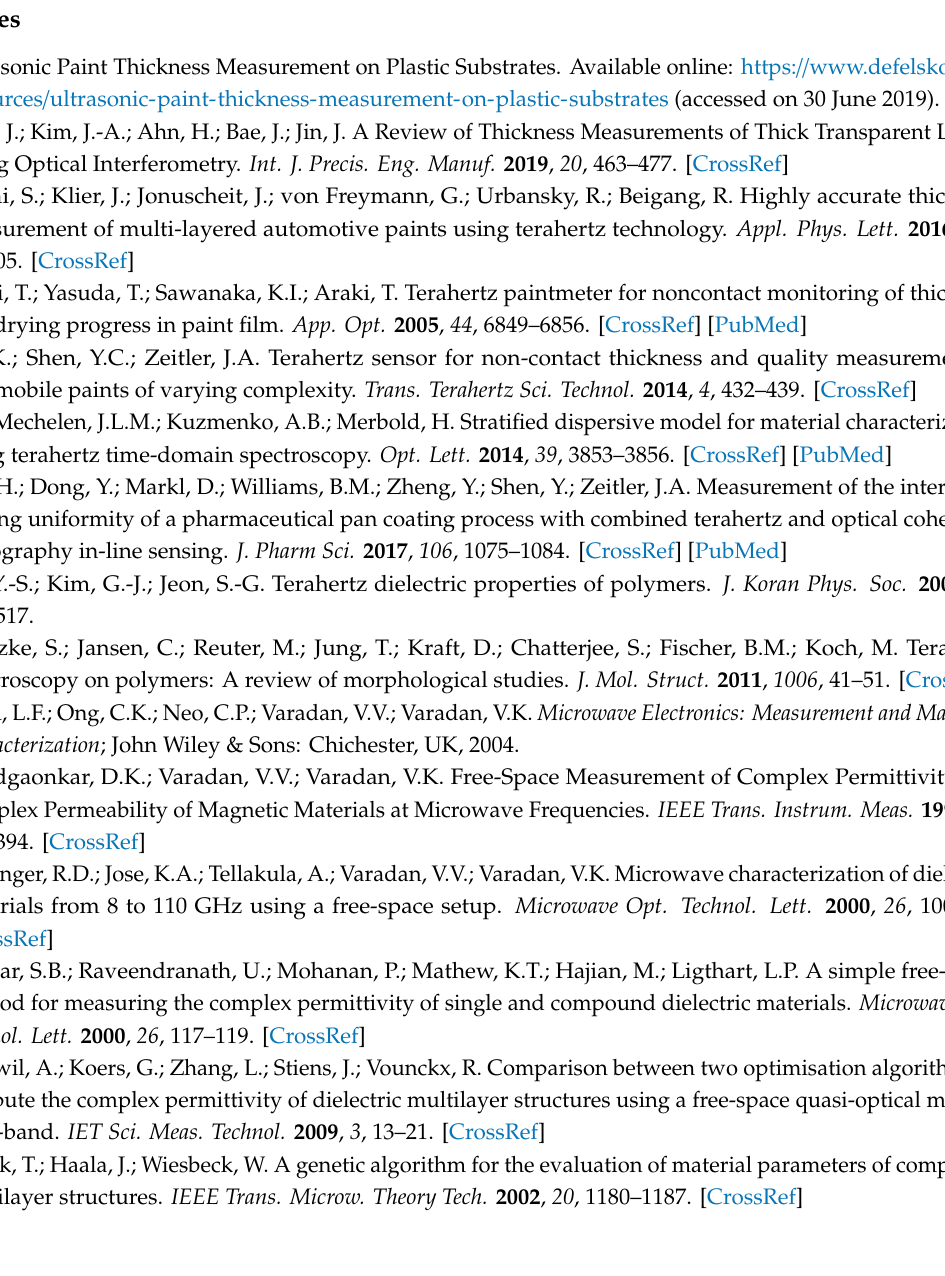
Figure S1: Color version of solution space of Figure